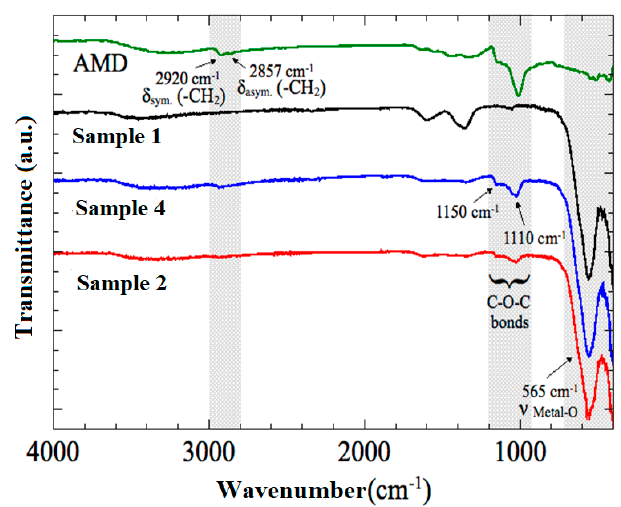
Figure 1. Fourier transform infrared (FTIR) spectra of sample 1 (cobalt ferrites), aminodextran (AMD) and, AMD-coated CoFe samples (sample 2 and sample 4).